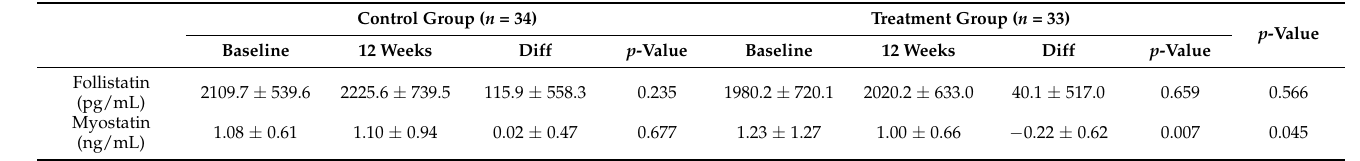
Table 5. Effects of tannase-treated green tea extract on hormones. Control Group ( n = 34) Treatment Group ( n =